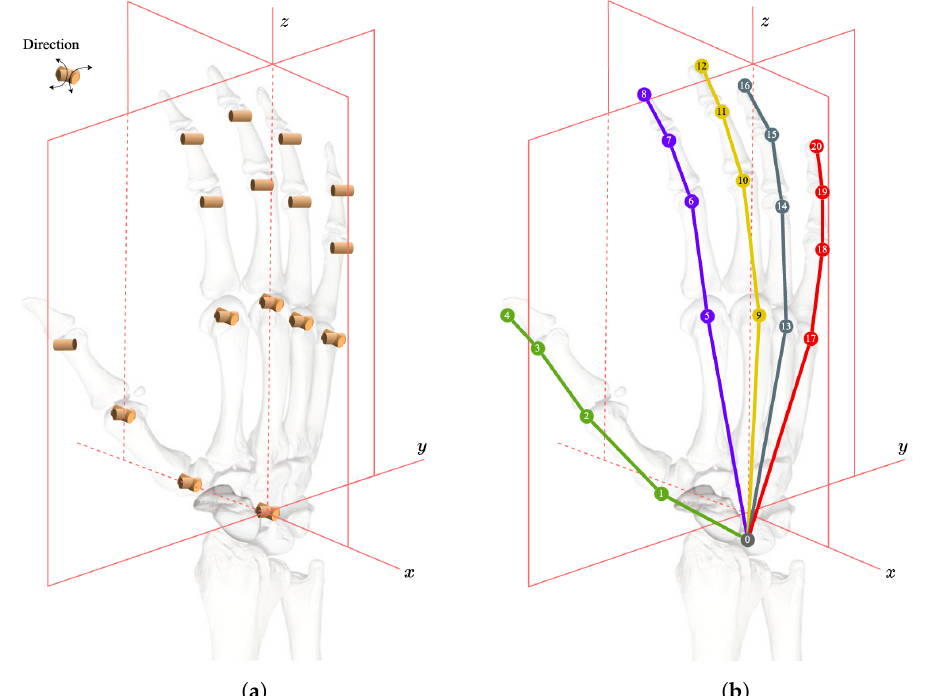
Figure 1. Biological characteristics of the human hand skeleton: ( a ) Illustration of the DoF of the hand; ( b ) Indices of the hand